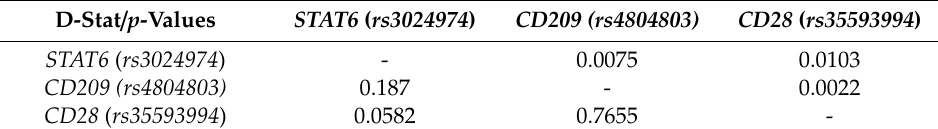
Table 5. Linkage disequilibrium analysis of STAT6 , CD209 and CD28 genetic polymorphisms.